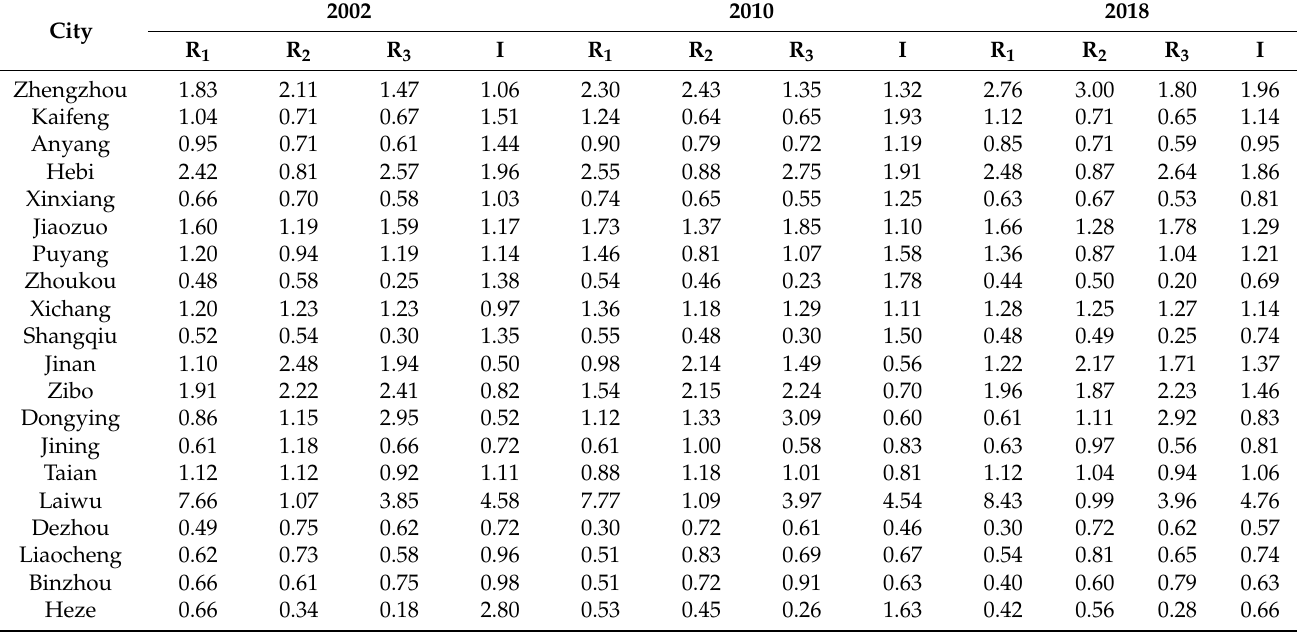
Table 1. Geographical concentration and coupling indexes of CLP and economic development in the